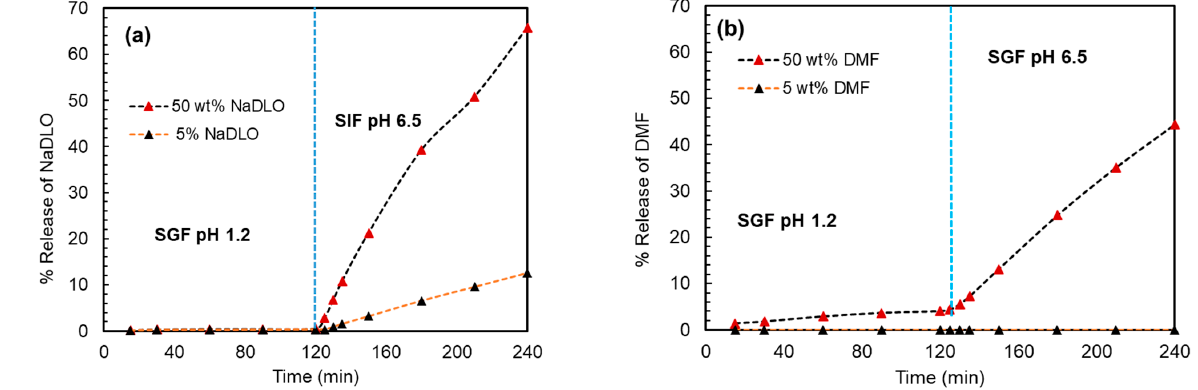
Figure 8. The release of ( a ) NaDLO from extruded samples with HPMC(P), and ( b ) DMF from extruded samples with HPMC(AS) under simulated gastric fluid (SGF) and simulated intestinal fluid (SIF) environments.